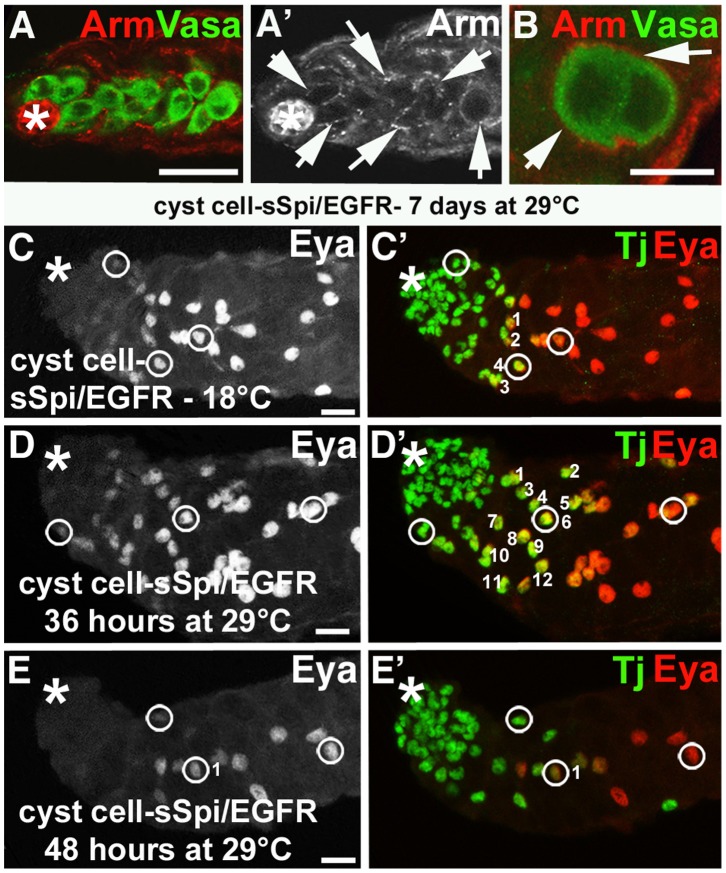
A high dose of EGF signaling promoted cyst cell differentiation.(A) Apical region of a testis from a cyst cell-sSpi/EGFR-animal showing that the germline cells (green) are enclosed by Arm-positive cytoplasmic extensions (red) of cyst cells. (A′) Same testis as in (A) showing the Arm-positive cytoplasmic extensions of cyst cells (arrows) only. (Note that not all cytoplasmic extensions are in focal plane) (B) A cluster of two spermatocytes (green) in a cyst cell-sSpi/EGFR-testes is enclosed in Arm-positive cyst cell cytoplasmic extensions (red, arrows). (C–E′) Apical regions of testes labeled with (left panel) only Eya and (right panel) co-labeled with Eya (red) and Tj (green). Cyst cells appear to accumulate Eya as they differentiate. The left-most circles in each testis show the most apical cyst cell nuclei that express low levels of Eya. These early-stage cyst cells also express high levels of Tj. The middle circles show cyst cells in the growth phase that express high levels of both, Eya and Tj. Small numbers indicate the numbers of the Eya+, Tj+-cells in one focal plane. The right-most circles show cyst cells after the growth phase expressing high levels of Eya, but low levels of Tj. Genotypes as indicated, scale bars: 30 µm.